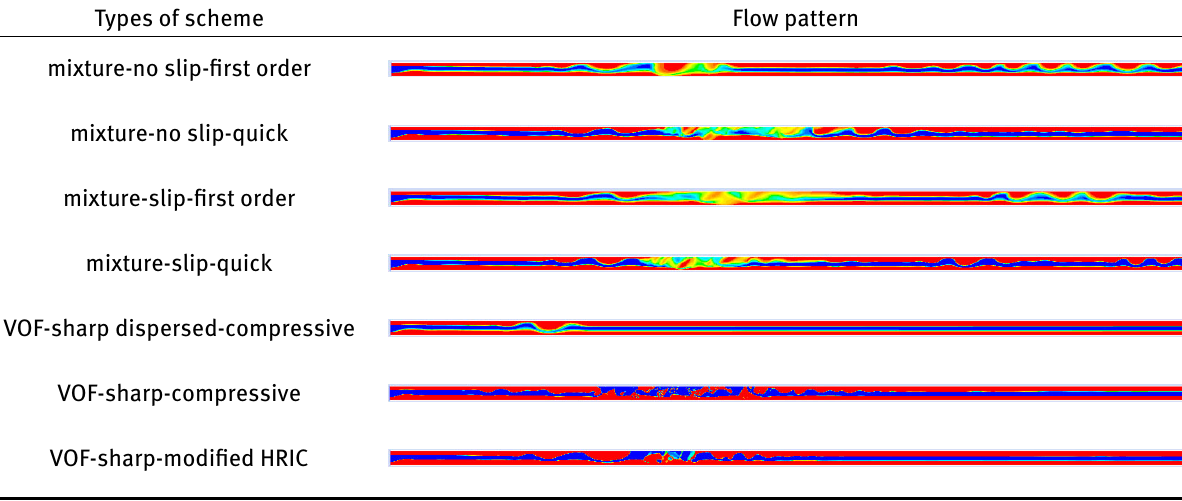
Table 18: Inter the kerosene from the middle for two-phase flow pattern, (L = 3 m, H = 5 cm), mesh (1,040,000) Types of